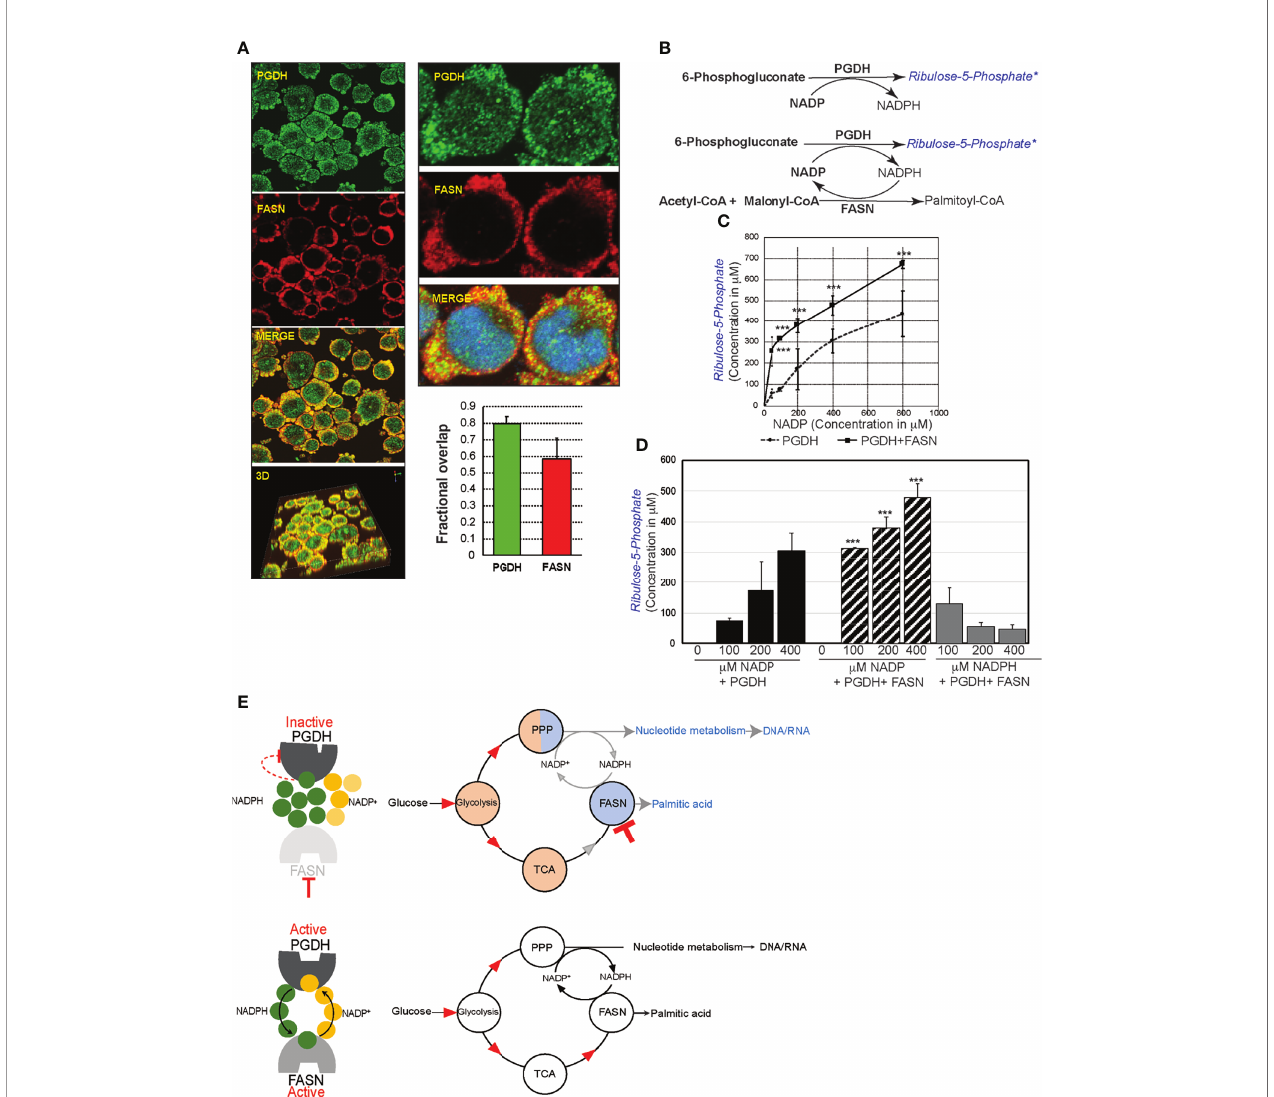
FIGURE 6 | FASN and phosphogluconate dehydrogenase (PGDH) are metabolically synergistic enzymes. (A) Confocal microscopy of SUDHL10 cells stained with rabbit anti-human PGDH (green) and mouse anti-human FASN antibody (red) as primary antibodies and donkey anti-rabbit AlexaFluor-488 and goat anti-mouse AlexaFluor-594 as secondary antibodies. Images were acquired using ×40 objectives and ×2.5 optical zoom, shown as individual channels or merged or 3D-rendered volume. Bar graph representing colocalization as overlap by correlation between PGDH and FASN expression, with error bars representing averages from an analysis of three independent images by ImageJ. (B) Schematic representation of cell-free assay experimental design. Shown in black are the reactants supplied in the reaction buffer, and shown in blue are the products. FASN – PGDH double-enzyme reactions were performed with either NADP or NADPH as cofactors. “ * ” refers to reaction product quanti fi ed by mass spectrometry. (C) Line graph representing ribulose-5-phosphate quanti fi cation (y-axis) by mass spectrometry from PGDH-catalyzed reaction consisting of increasing concentrations of NADP (x-axis). (D) Bar graph representing the quanti fi cation of ribulose-5-phosphate (y-axis) and comparison of increasing concentrations of NADP- driven PGDH or PGDH+FASN-catalyzed reaction and NADPH-driven PGDH+FASN-catalyzed reactions. The error bars represent the standard deviations of mean and the signi fi cant differences between each concentration of NADP-driven PGDH reaction, with NADP- or NADPH-driven PGDH+FASN-catalyzed reaction indicated by an asterisk (*** p < 0.001). (E) Diagram representing the allosteric stimulation or inhibitory effects of NADP + and NADPH on PGDH and summarizing the impact of FASN inhibition on overall metabolic pools (shaded in red indicating increases or blue indicating decreases) in comparison with metabolic fl ow in uninhibited